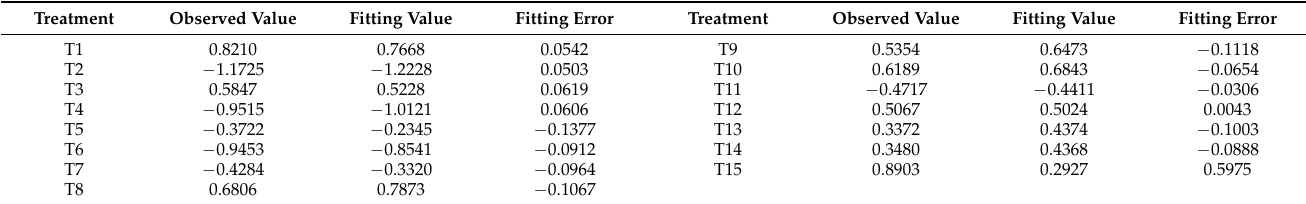
Table 7. Observed and predicted values of the comprehensive evaluation